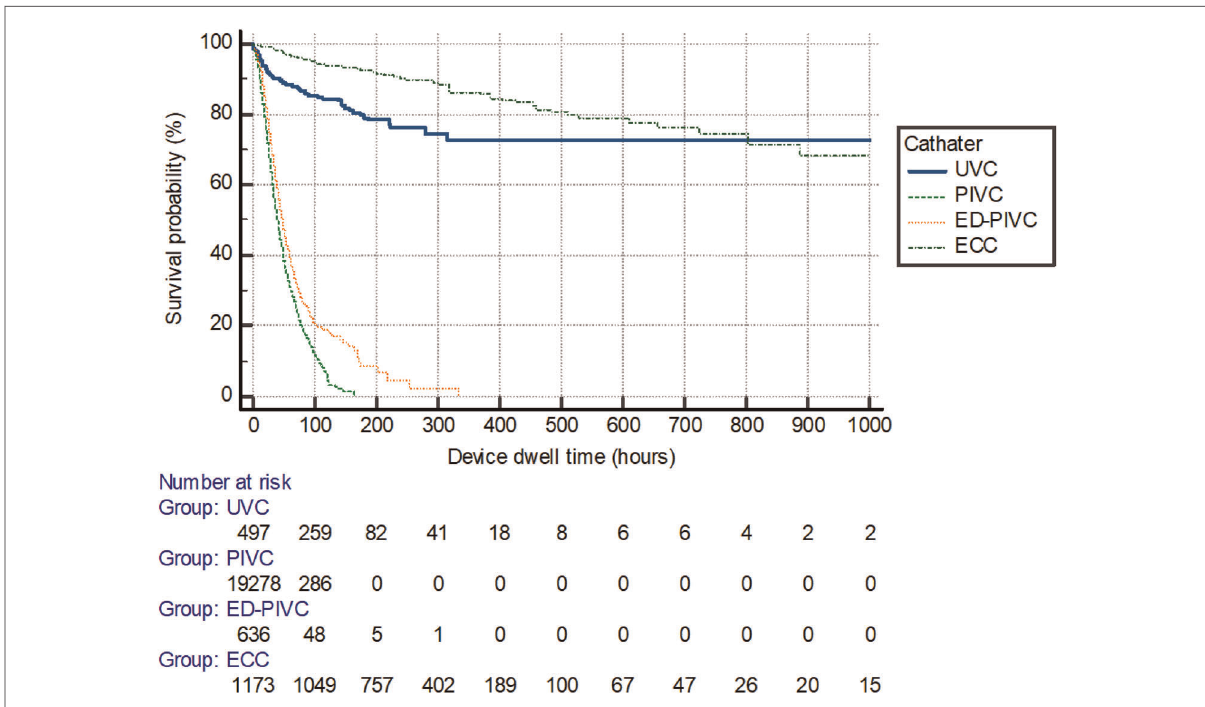
FIGURE 2 Survival curve per catheter device type for dwell time duration. UVC, umbilical venous catheter; PIVC, peripheral intravenous catheter; ED-PIVC, extended dwell-peripheral intravenous catheter; ECC, epicutaneo-caval catheter.